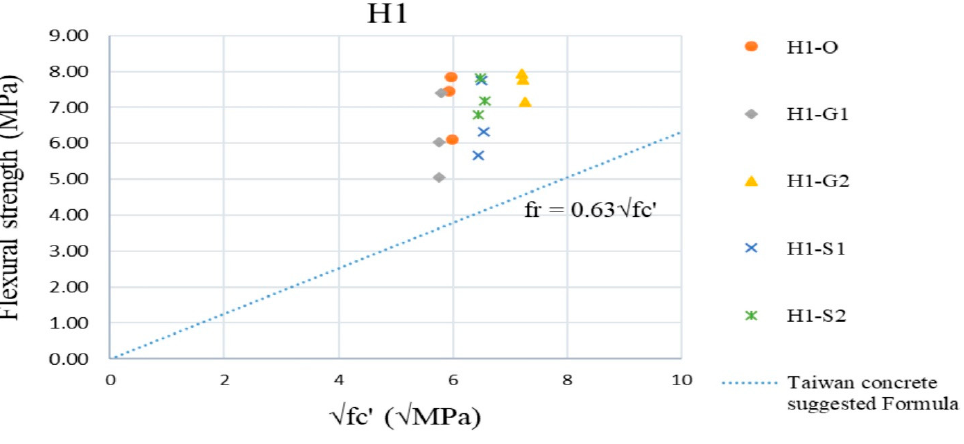
√ Figure 14. Relationship between flexural strength and √ fc ′ for H1 high-strength pervious concrete. Figure 14. Relationship between flexural strength and √ fc ′ for H1 high-strength pervious concrete. Figure 14. Relationship between flexural strength and fc (cid:48) for H1 high-strength pervious concrete. Figure 14. Relationship between flexural strength and √ fc ′ for H1 high-strength pervious concrete.